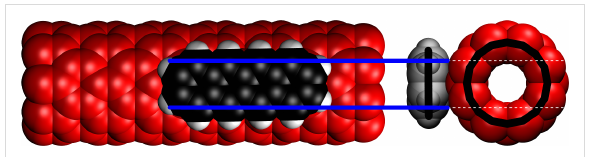
Figure 6: The contact zone of an (8.0)-CNT/tetracene complex. The bold black lines in the traverse section represent the positions of the nuclei. Reprinted with permission from [44], copyright 2017